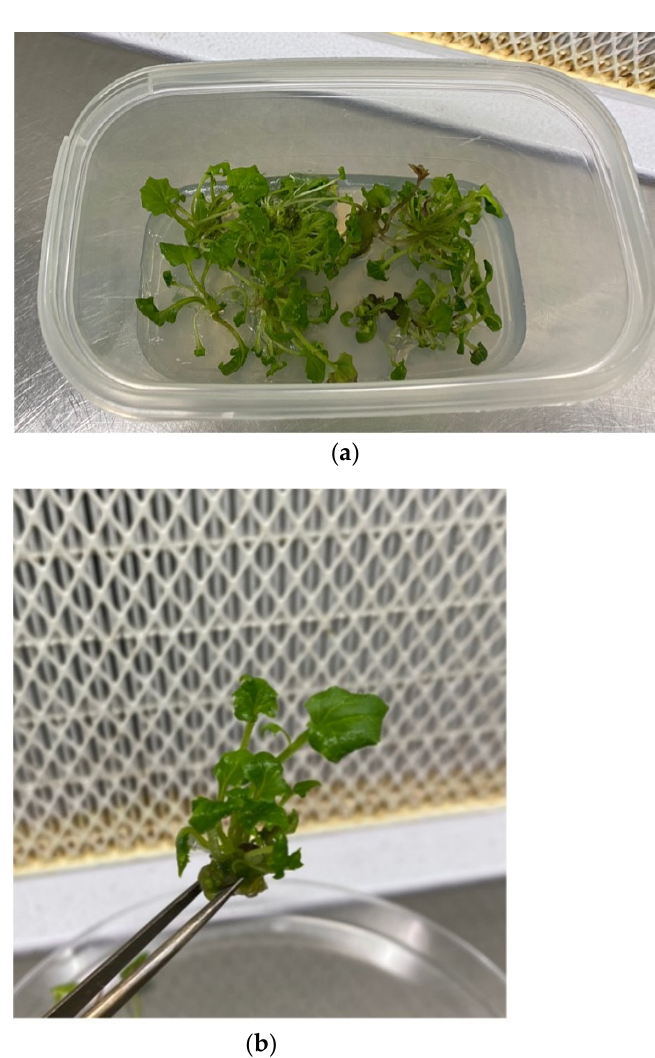
Figure 4. In vitro shoot development of Adenostyles alpina subsp. macrocephala in the culture medium containing 3 mg L ⁻ ¹ BAP and 1 mg L ⁻ ¹ NAA ( a , b ).